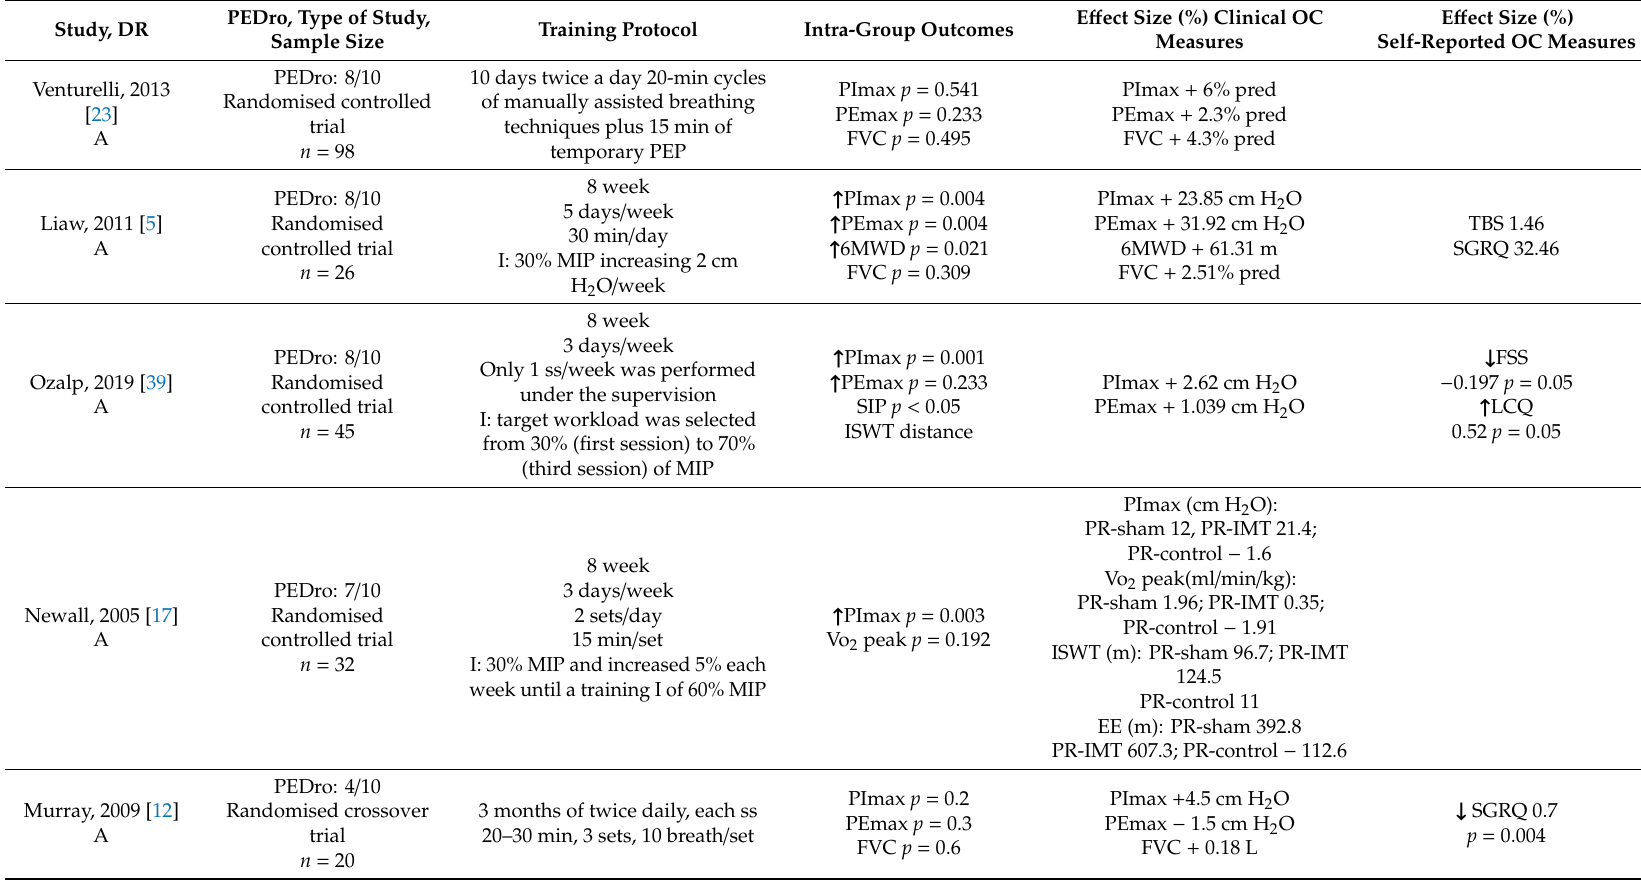
Table 2. Key findings of primary